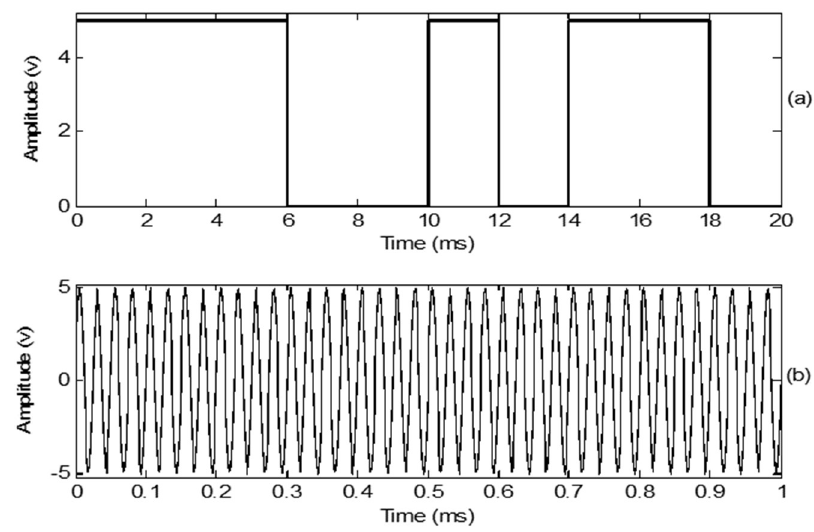
Figure 4. ( a ) Baseband digital signal at 500 bps; ( b ) Carrier signal at 40 kHz.